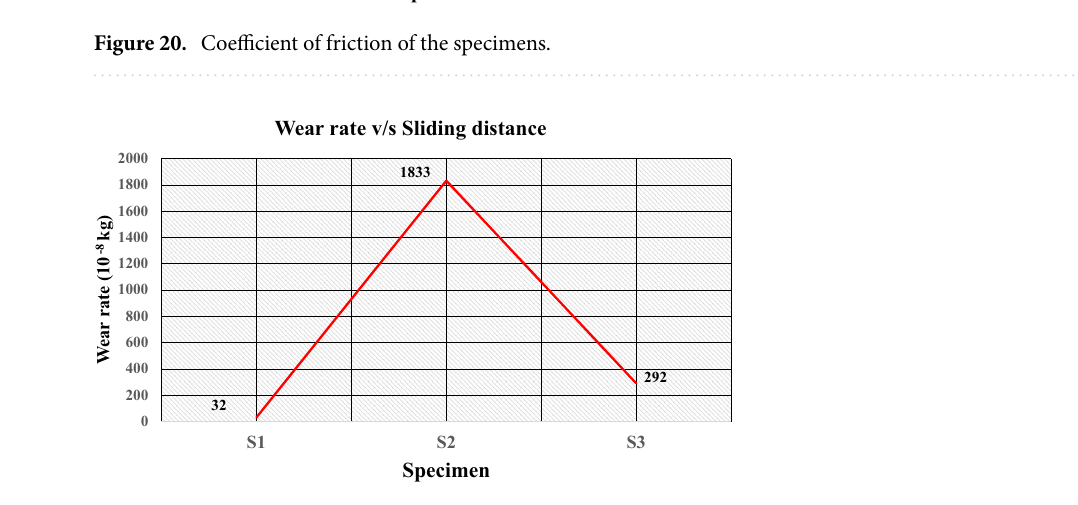
Figure 21. Wear rate of the specimens at sliding distance of 226